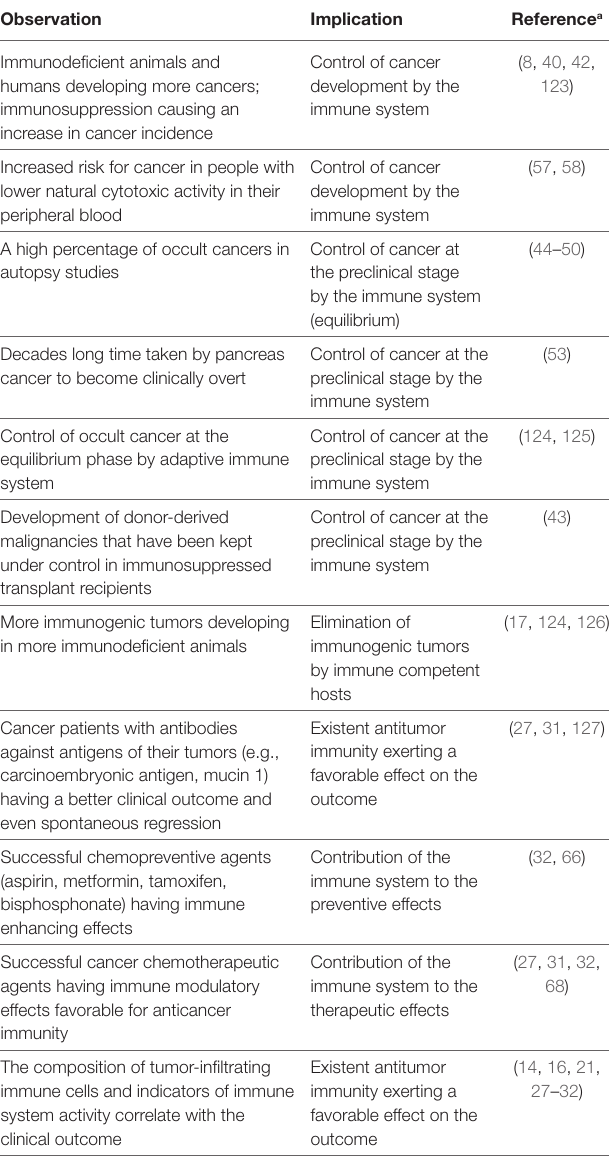
TAbLe 2 | evidence for immune surveillance against the development of cancer and for the control of existing